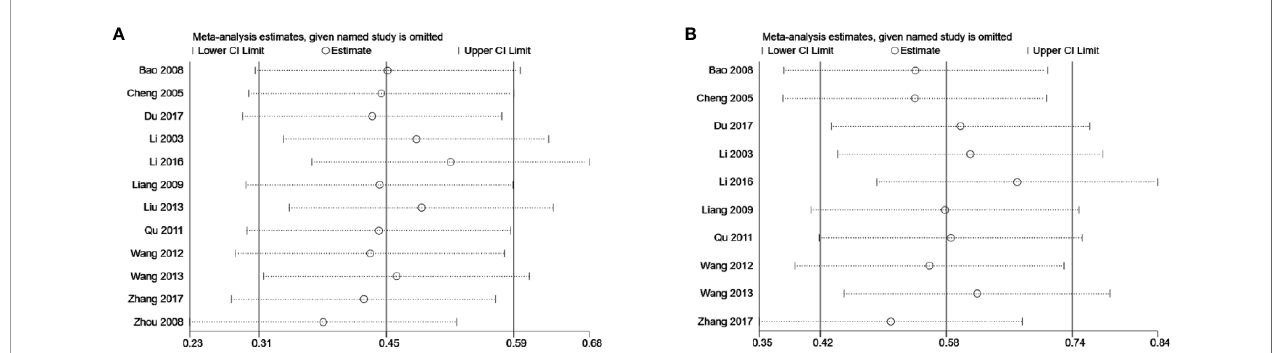
FIGURE 11 | Sensitivity analysis plots of (A) SCr and (B)